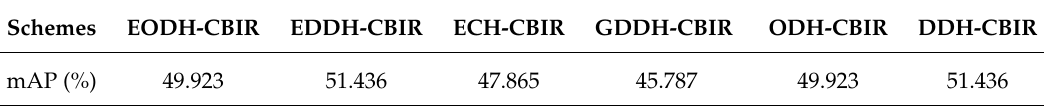
Table 4. The retrieval accuracies of different schemes. EODH-CBIR: encrypted order